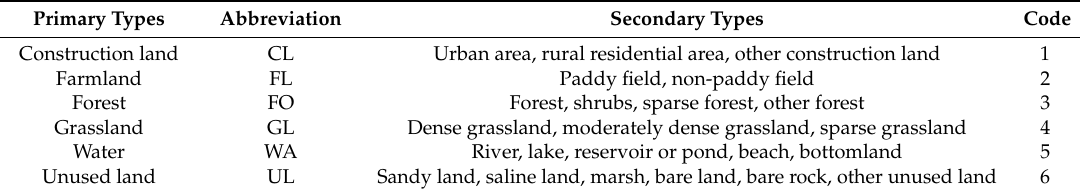
Table 2. Land use/land cover type classification system used in this